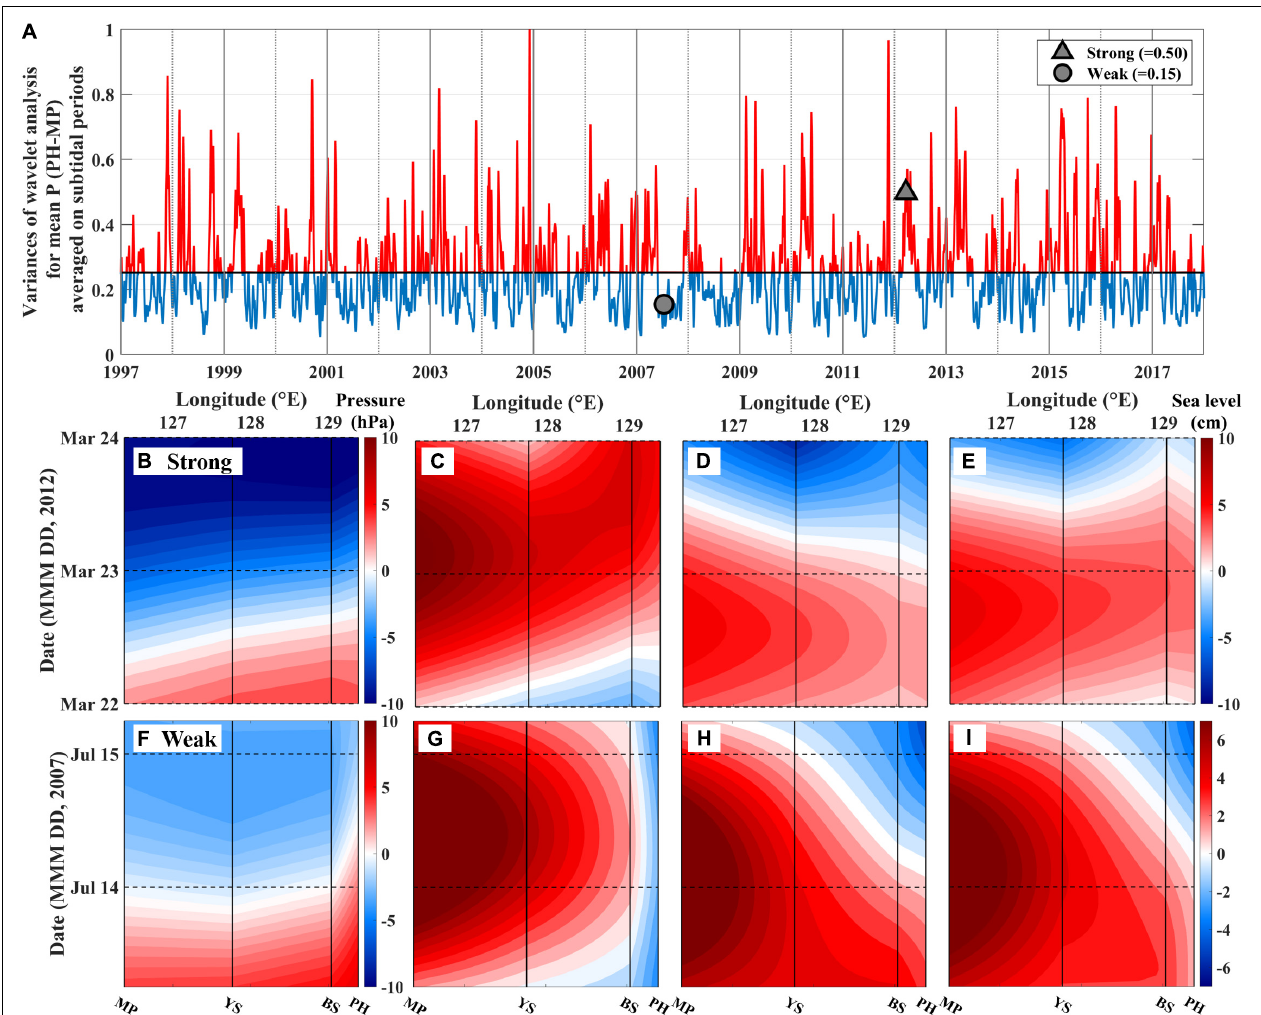
FIGURE 10 | (A) Time-series of variance in the wavelet analysis for subtidal periods of atmospheric pressure fluctuations. The black solid line denotes the mean ( = 0.25) of the variance of the total period, and the red and blue lines show the period with the stronger and weaker subtidal fluctuations in the atmospheric pressure than the mean value. The gray triangle and circle denote the events for the examples of strong (B–E) and weak (F–I) subtidal fluctuation in atmospheric pressure on the lower panels. Time-longitude patterns of (B,F) the atmospheric pressure anomaly and sea levels without (C,G) and with inverse barometric (D,H) , and with the integrated response of non-isostatic and standard inverse barometric (E,I) corrections for the atmospheric pressure loading at four TG stations (MP, YS, BS, and